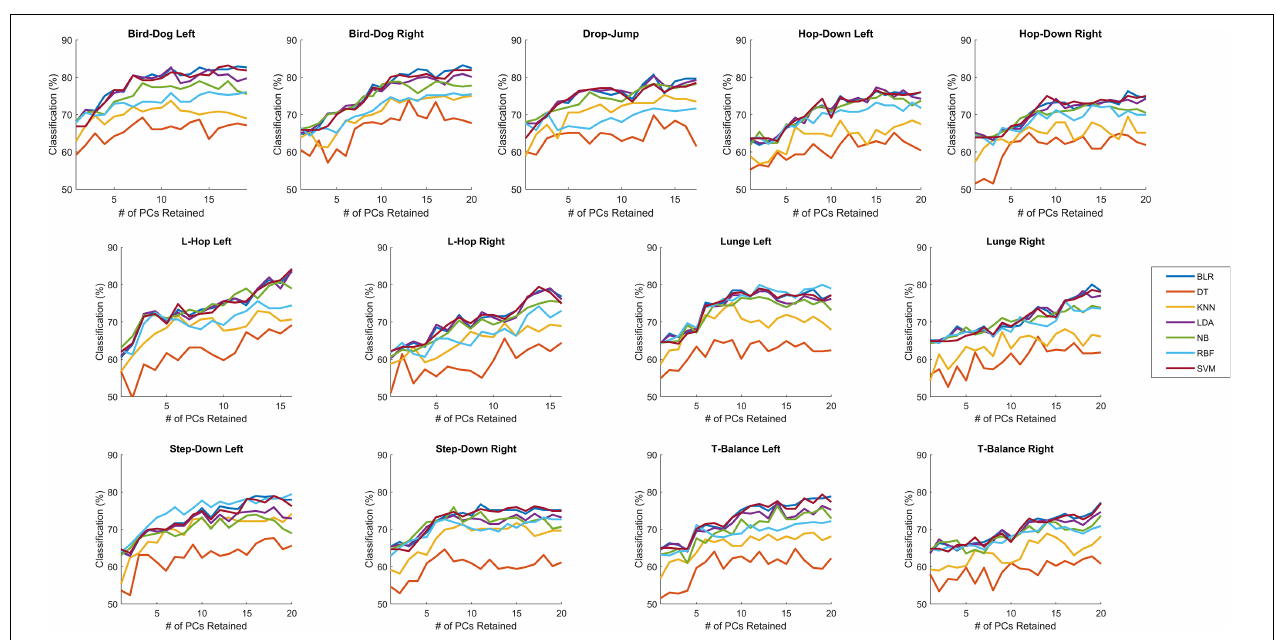
FIGURE 2 | OPT: The percent of correctly classified athletes as either elite or novice for when 1 to the total number of PCs retained were retained for binary logistic regression (BLR), decision tree (DT), linear discriminant analysis (LDA), k-nearest neighbors (kNN), naïve Bayes (NB), support vector machine with a linear kernel (SVM), and support vector machine with a radial basis function kernel (RBF) with leave-one-out validation for OPT. See number of PCs retained in Table 1 .